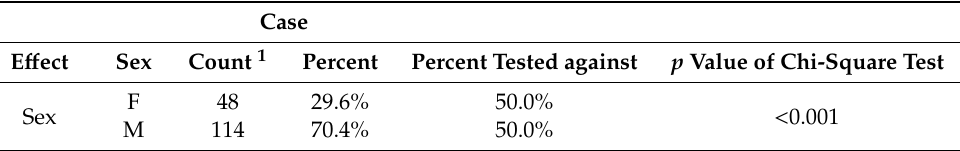
Table 4. Statistical analysis of sex effect on acute cytauxzoonosis case incidence.